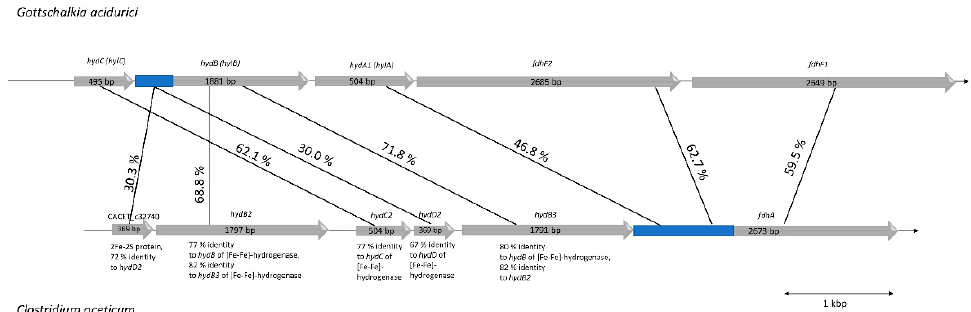
Figure 7. Genetic organization of the potential formate dehydrogenase ( fdh ) gene cluster in C. aceticum compared to the fdh gene cluster of G. acidurici . Genes coding for a potential electron-bifurcating formate dehydrogenase in C. aceticum are organized in a cluster consisting of six genes, whereas in G. acidurici there are only five [39]. The first one is CACET_c32740 coding for a 2Fe-2S protein (HydD3), which has 72% similarity to HydD2, another protein encoded in the fdh operon (CACET_c32710). Both genes are not found in the fdh gene cluster of G. acidurici , but they are both similar (around 30%) to the first 180 amino acids of HylB (encoded by Curi_c29400). HydB2 (encoded by CACET_c32730) and HydB3 (encoded by CACET_c32700) in C. aceticum share 82% identity and are both similar to HylB of G. acidurici . HydC2 (encoded by CACET_c32720) of C. aceticum is 62% similar to HylC of G. acidurici (Curi_c29410). In contrast to G. acidurici , which has two fdhF genes (Curi_29370 and Curi_29380), C. aceticum possesses only one gene (CACET_c32690) coding for a formate dehydrogenase (FdhA), which is around 60% homologous to both FdhFs of G. acidurici . The fdh gene cluster of C. aceticum is flanked upstream by CACET_c32750, which has similarity with a HPr kinase (a phosphocarrier protein of the phosphoenolpyruvate-dependent sugar phosphotransferase system) and downstream by CACET_c32680, which has similarity with a ru-